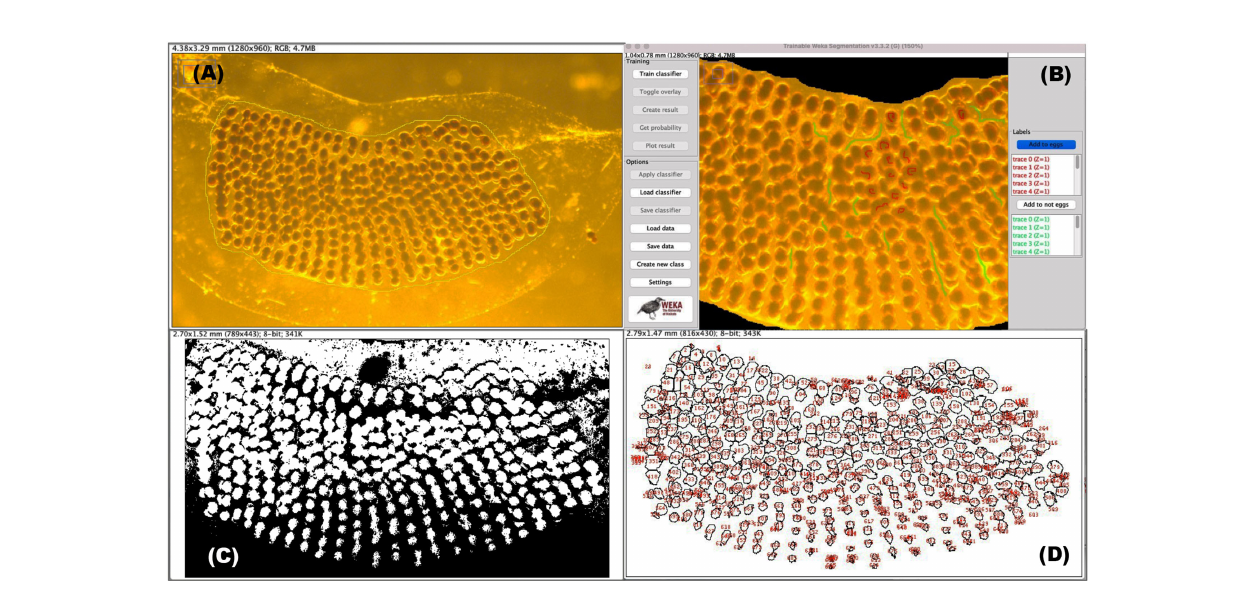
FIGURE 4 | Work fl ow steps leading to egg enumeration using supervised machine learning. (A) Selection of the area surrounding all eggs by using the “ freehand ” tool. (B) Supervised training in the TWS graphical user interface corresponding to eggs (default red) and non-egg (default green) regions. (C) Segmentation is fi rst achieved by using a binary image (which is generated by the TWS plugin) prior to employing the watershed function. (D) Selecting “ Analyse > Analyse Particles …” gives a results table (not shown) and this image window showing estimations of egg each numbered in